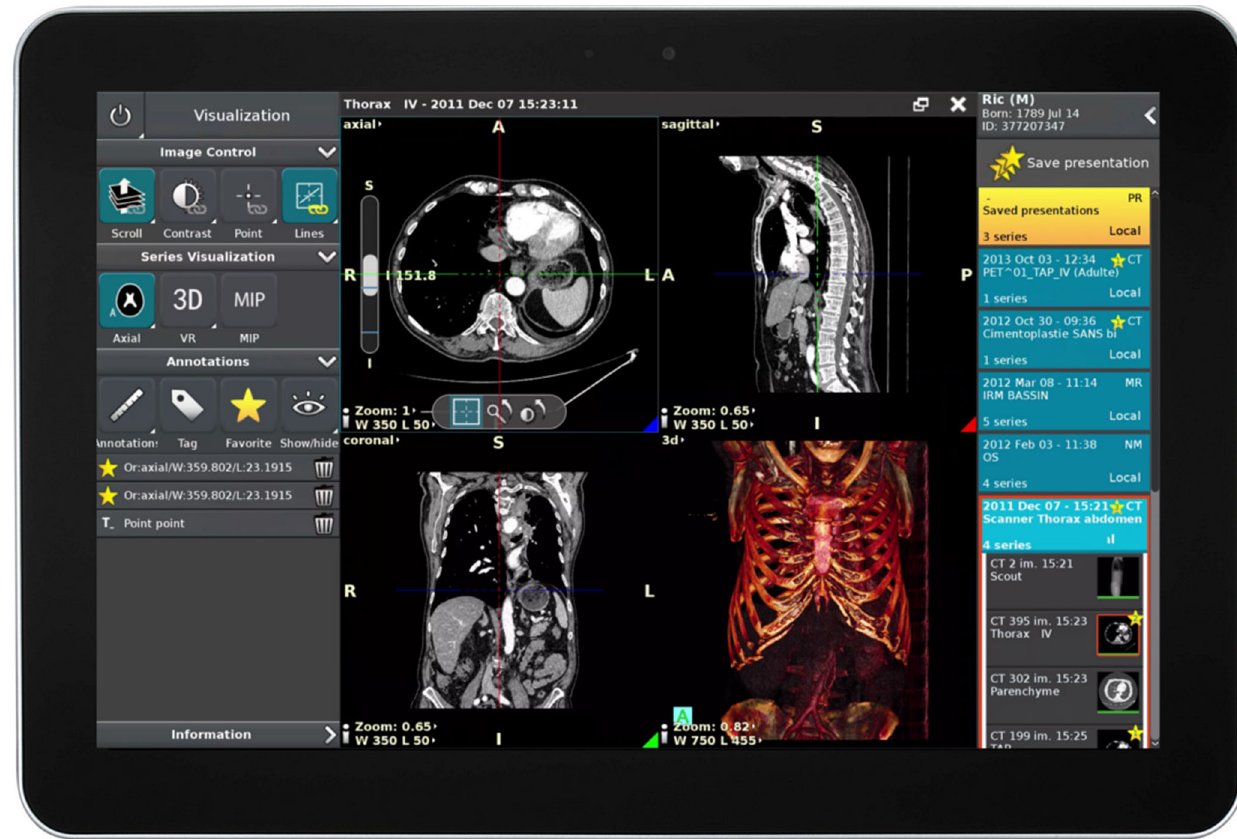
Fig. 5 Tactile version of the Anywhere viewer (Therapixel, France). Cloud computing allows powerful post-processing with online PACS